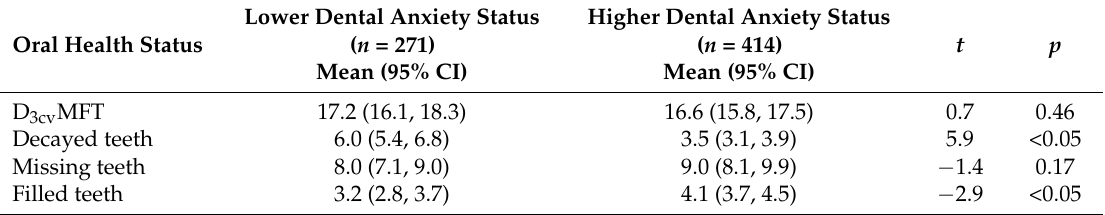
Table 3. Comparison of low and high dental anxiety status with oral health status.